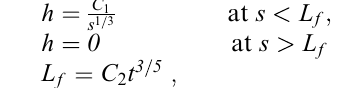
conditions show the similar behaviour. The computed location of the bottom front versus time is shown in Fig. 7 together with the analytical solution (23) and experimental data.